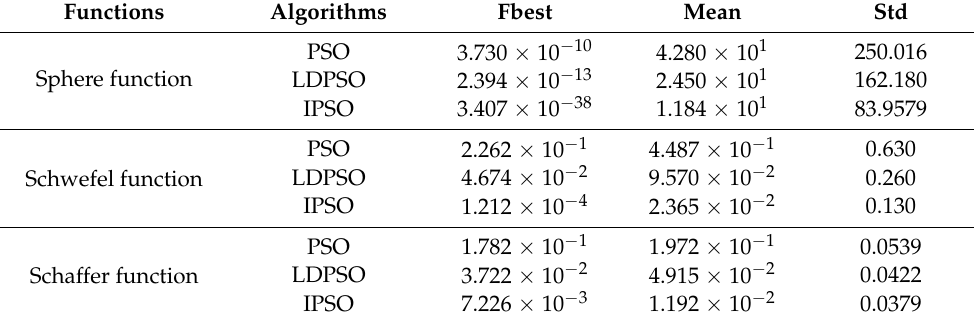
Table 2. Results of the test